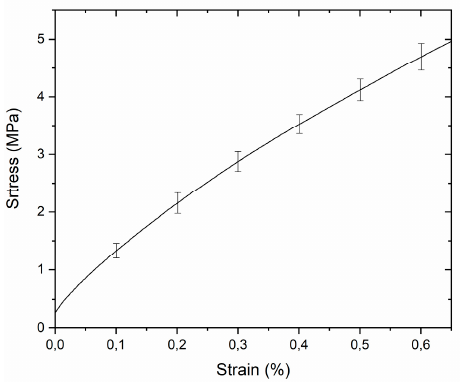
Figure 3. Resulting stress/strain curve in the linear-elastic range of the tensile strength of a PEN/SU- 8 hybrid device.